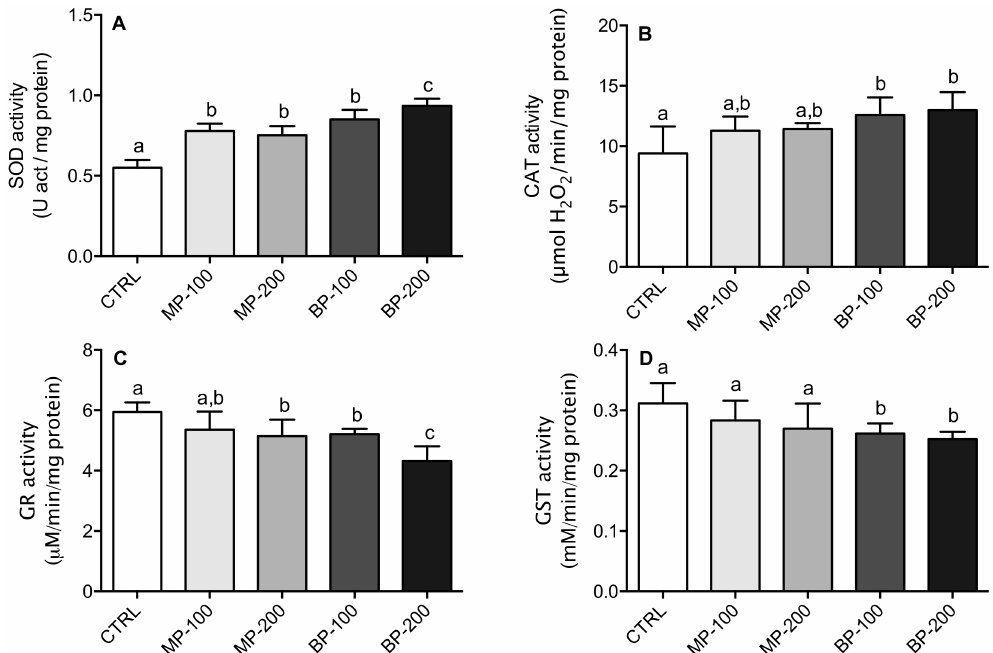
Figure 6. Activity of oxidative stress enzymes in testes of F1 generation rats: ( A ) superoxide dismutase (SOD), ( B ) catalase (CAT), ( C ) glutathione reductase (GR), and ( D ) glutathione S -transferase (GST). Results are M ± SD of 7–10 independent experiments. The values marked with the same letter are not statistically significant between groups as determined by the Tukey’s post hoc test ( p <